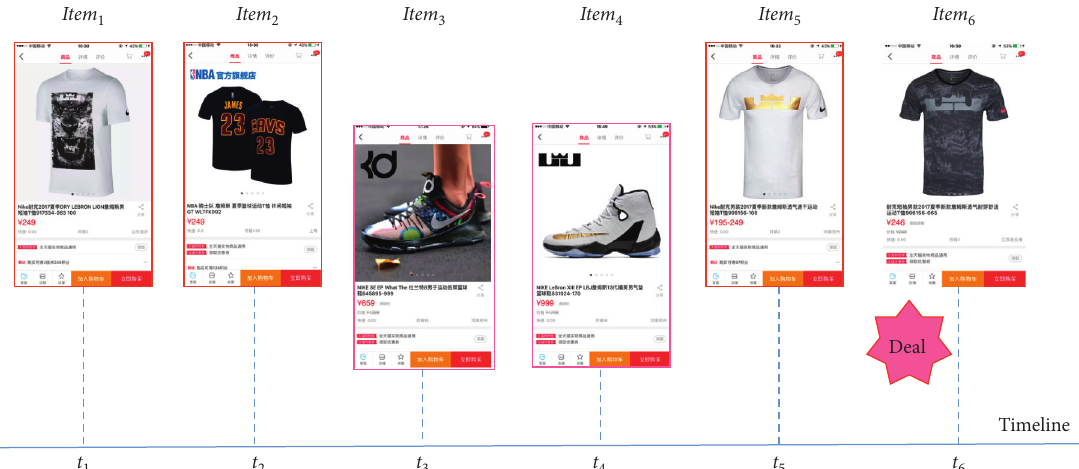
Figure 1: An example of sequential actions of a user in one of the largest online e-commerce platforms. The user clicked several items sequentially and finally purchased Item . The red frame around each item indicates the corresponding (estimated) contribution of that item 6 to the final deal; darker color stands for more contribution.